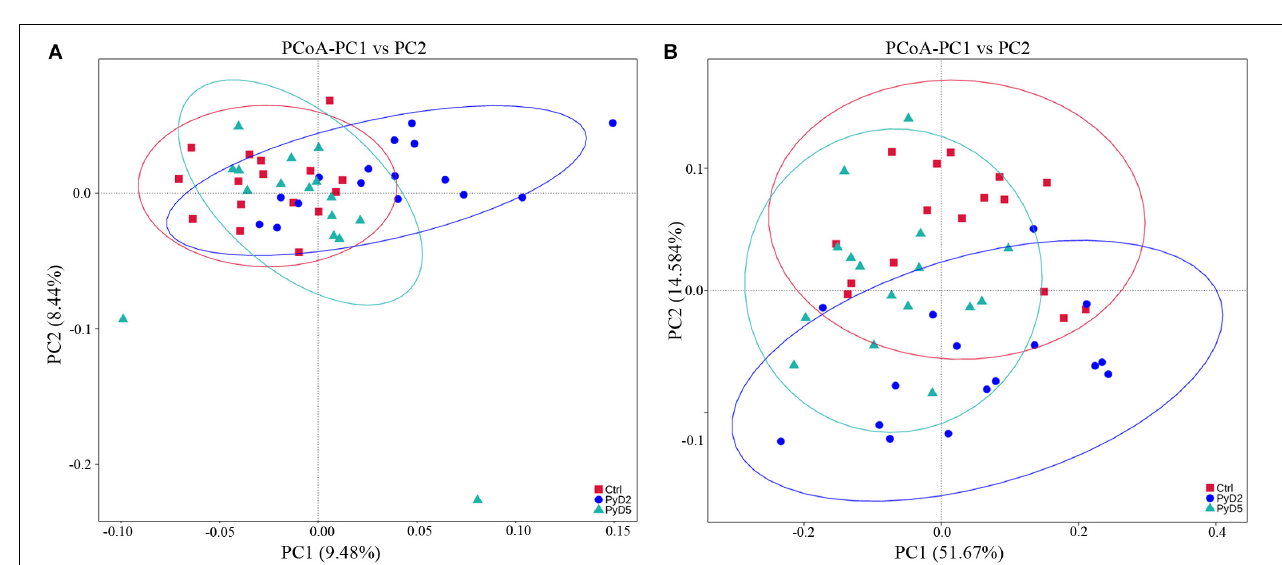
FIGURE 4 | Principal coordinates analysis (PCoA) based on unweighted (A) and weighted (B) Unifrac distance matrices of fecal samples of BALB/c mice during infection. The fecal bacterial community components of both Py 17XL-infected and -uninfected mice were represented. Sample names are described in Table 1 .